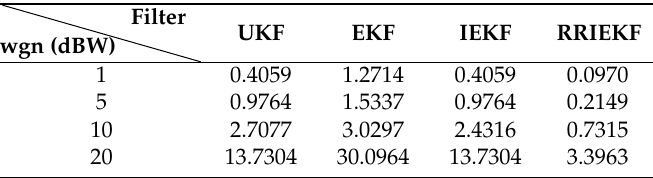
Table 3. Estimation errors for different filters.